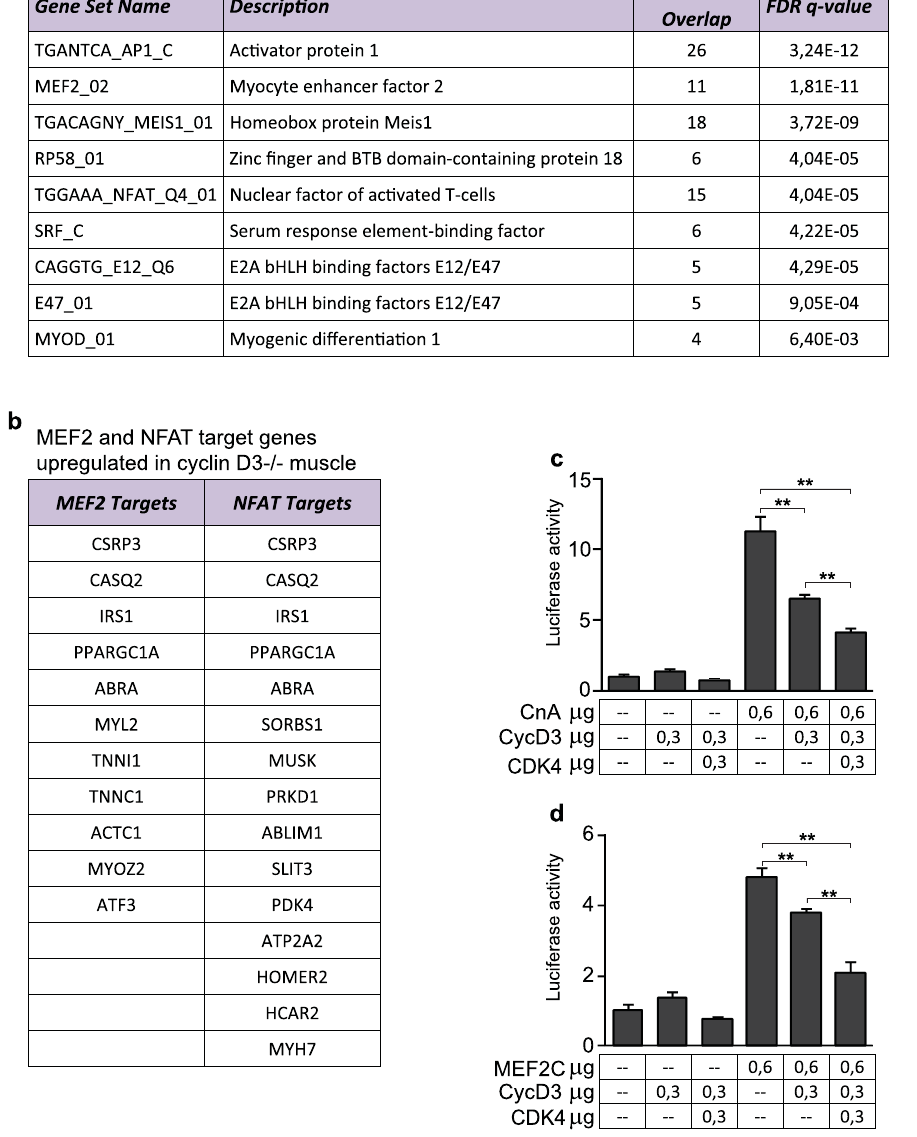
Figure 7. Cyclin D3 regulates the expression of MEF2 and NFAT target genes. ( a ) Transcription factor- binding motifs enriched in the promoter region of genes upregulated in cyclin D3 − / − muscle. Enrichment analysis of 77 selected genes upregulated in cyclin D3 − / − muscles performed on gene sets derived from the Transcription Factor Targets (TFT) sub-collection of the Molecular Signature Database (MSigDB: http:// software.broadinstitute.org/gsea/msigdb/index.jsp). Each TFT gene set is associated to number of genes and FDR q-value ( < 0.05). ( b ) MEF2 and/or NFAT target genes upregulated in cyclin D3 − / − muscle. List of genes upregulated in cyclin D3 − / − muscle overlapping the MEF2 and/or NFAT gene sets from the MSigDB TFT collection. ( c , d ) Cyclin D3 represses the calcineurin-stimulated (panel c) or MEF2C-stimulated (panel d) activity of the myoglobin (Mb) gene promoter. C2 muscle cells were transiently transfected with the Mb- luciferase reporter plus either empty expression vehicles (–) or the indicated combinations of plasmids encoding activated calcineurin (CnA), MEF2C, cyclin D3 (D3) or CDK4. Data are expressed relative to the luciferase activity measured in the control state (co-transfection with empty vectors), and represent mean values ± SEM from four independent transfections. Statistical differences between WT and D3 − / − mice was assessed by two- tailed unpaired t-tests ( ** p <